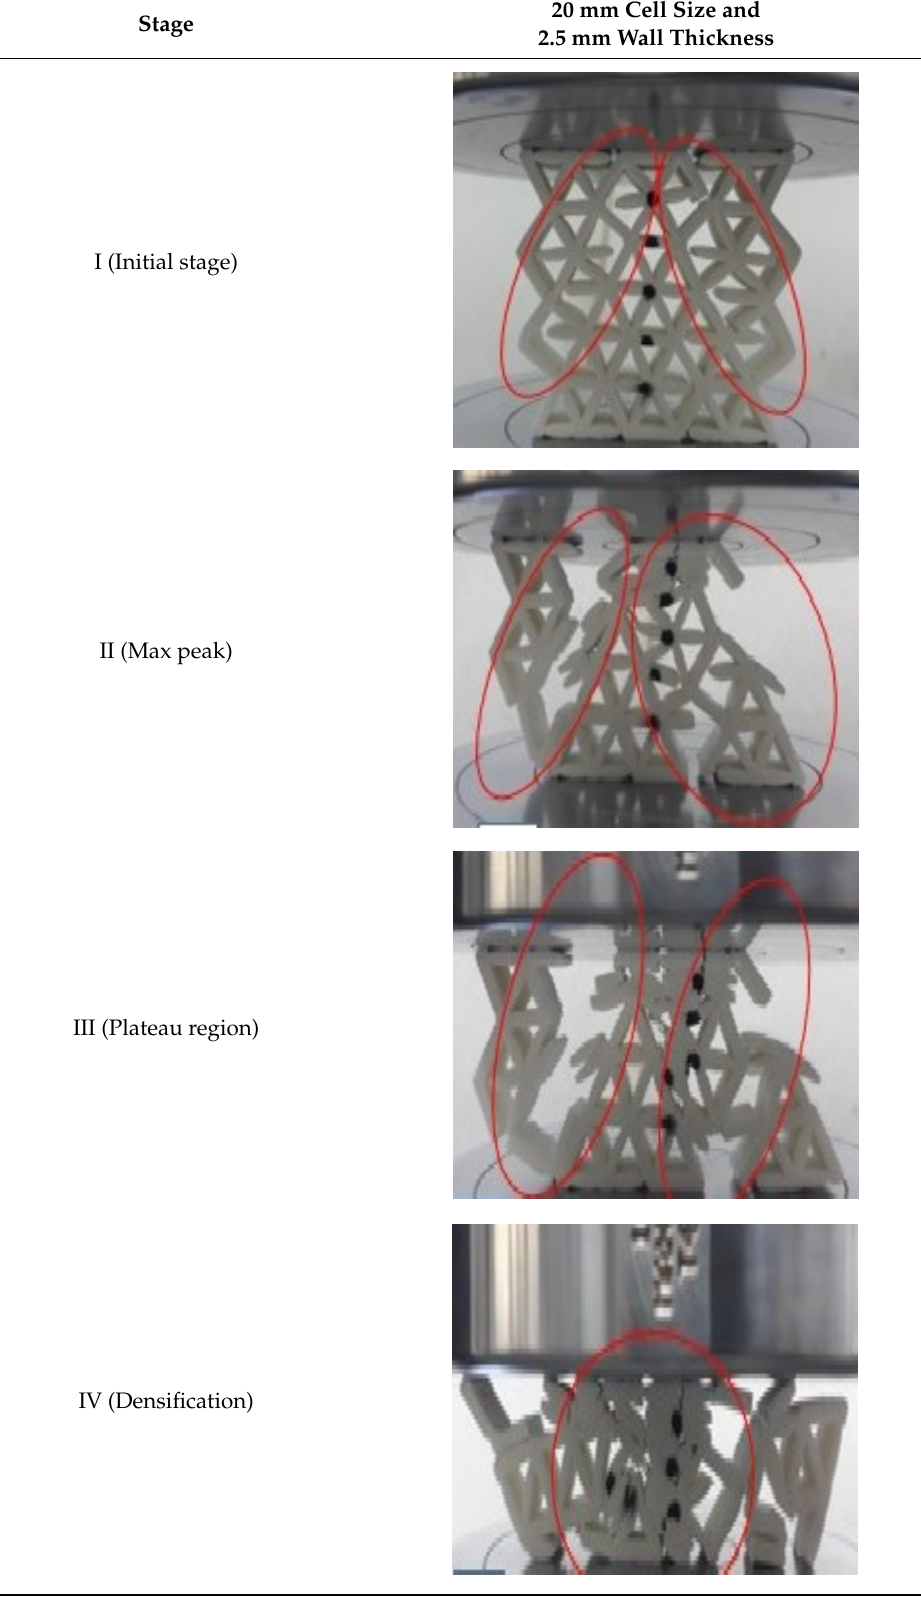
Table 3. Failure sequence of the structure with 20 mm cell size and 2.5 mm wall thickness.